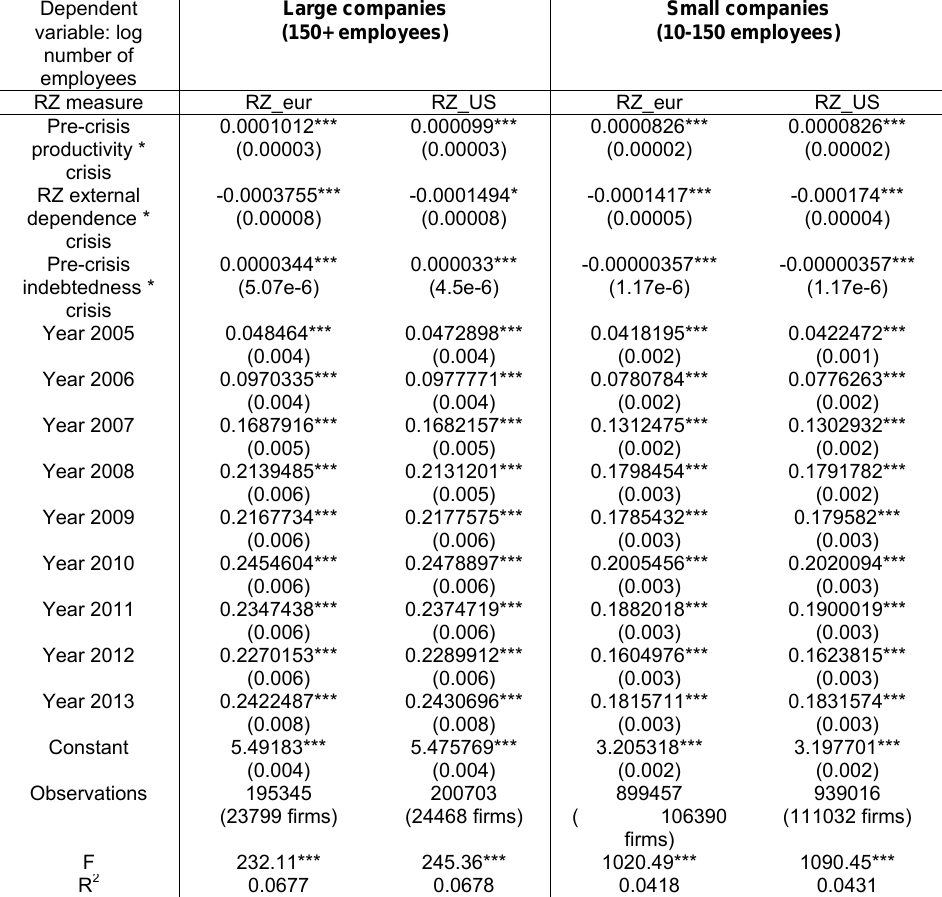
Table 5. Main regression, large and small firms Dependent variable: log number of